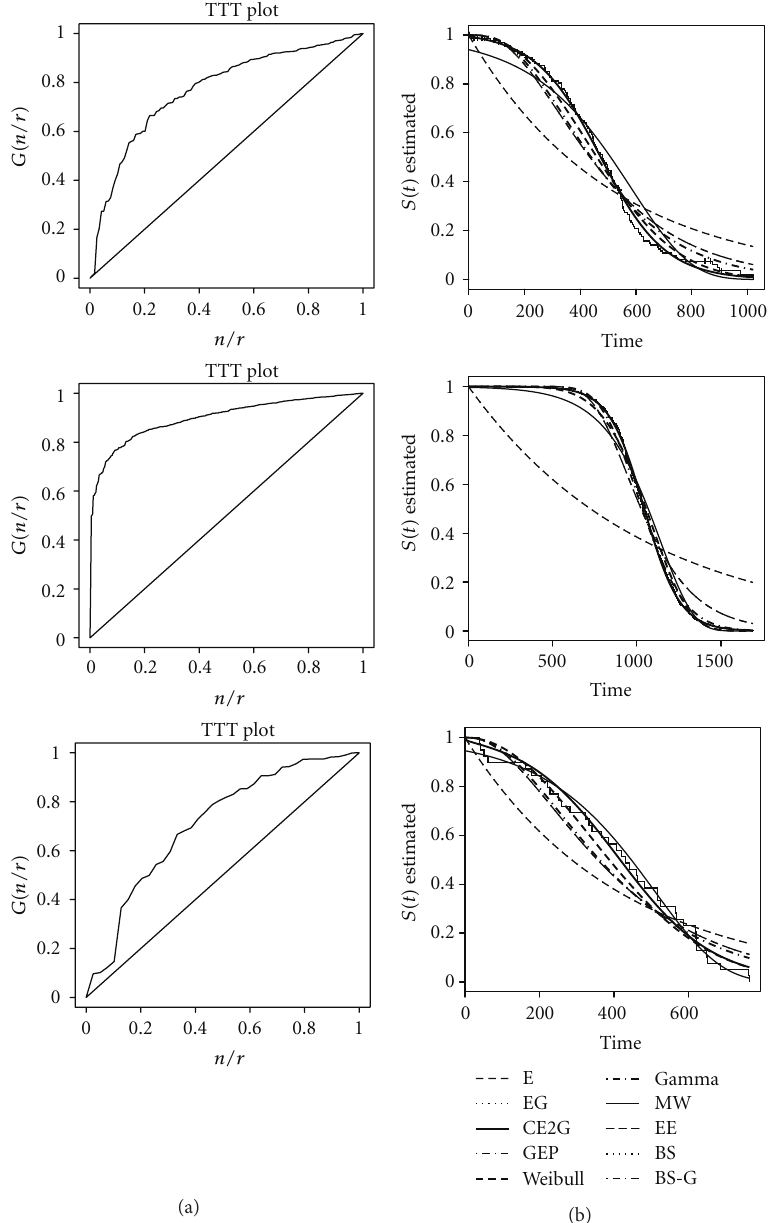
Figure 3: (a) Empirical TTT plot for the dataset 𝑇1 , 𝑇2 , and 𝑇3 , respectively. (b) Models fitting for the dataset 𝑇1 , 𝑇2 , and 𝑇3 , respectively.